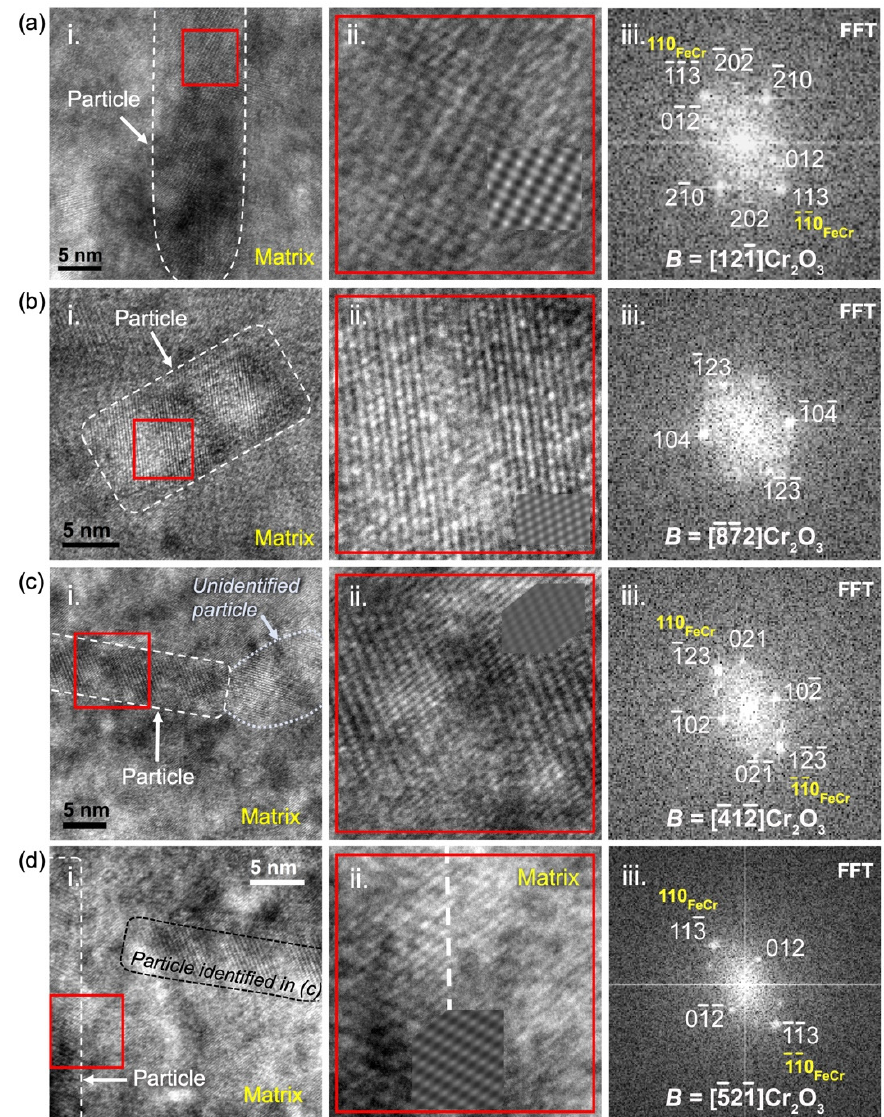
Figure 4. HRTEM imaging of precipitates synthesized with Ti → Y → O implantations and subse- quent thermal annealing at 800 °C for two hours. A selection of four precipitates is displayed from sub-figure ( a – d ). In panel (i), the studied precipitates are outlined with a white dashed line. A red square indicates the region selected for FFT calculation, which is enlarged in panel (ii). The calculated FFT is reported in panel (iii) with identified structure and zone axis, as well as a corresponding indexation of spots deduced from the FFT analysis and simulation of the HRTEM pattern, which is reported as an insert in panel (ii). Unindexed spots on the FFT originate either from the matrix (un- identified reflections) or from a spinel surface oxide.